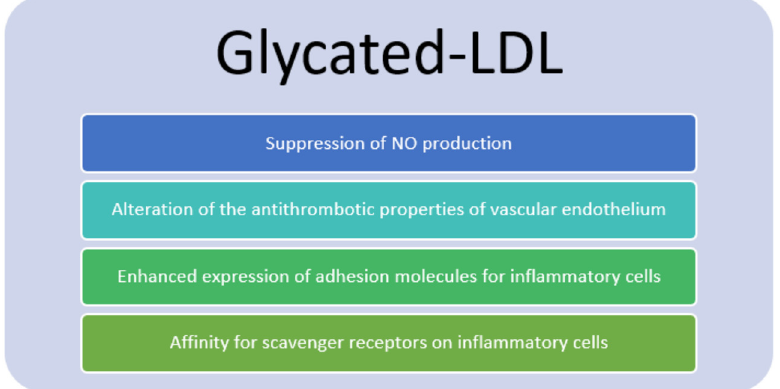
Figure 4. Proprieties of Glycated LDL (Glycated LDL: Glycated low-density lipoprotein, NO: nitric oxide).